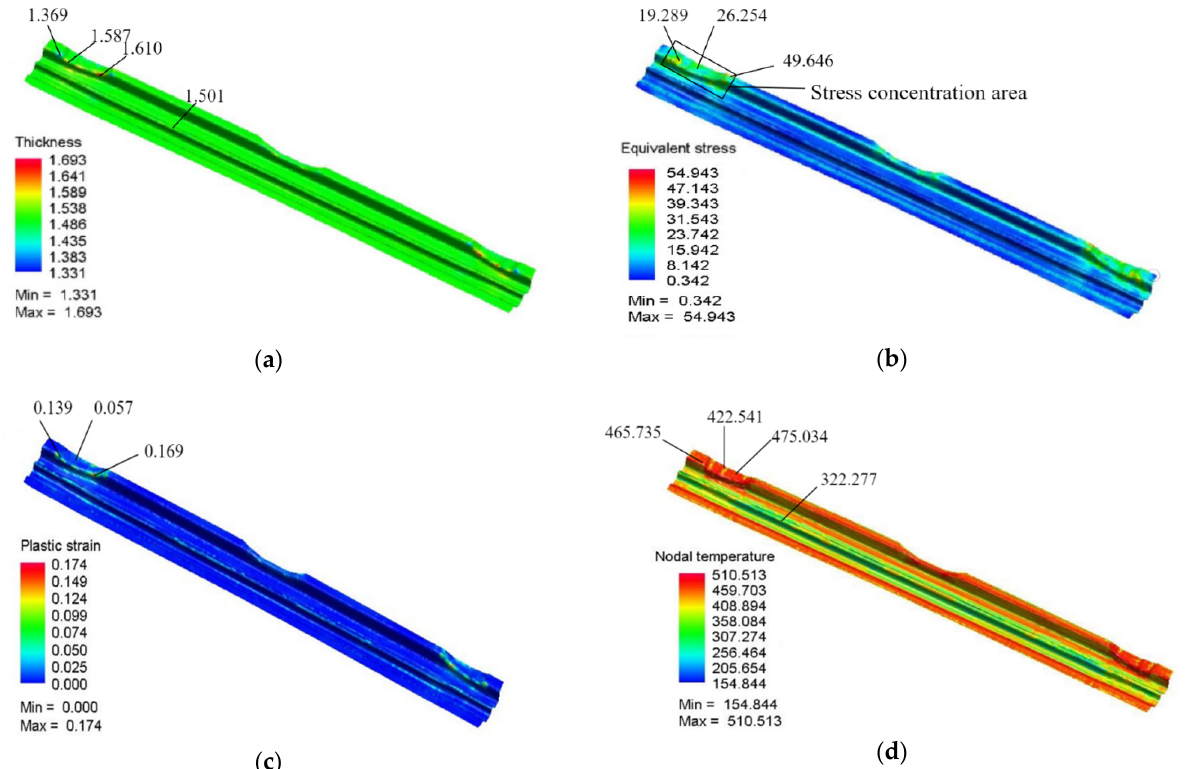
Figure 7. Distribution of simulation results: ( a ) Thickness distribution, ( b ) Stress distribution, ( c ) Strain distribution, and ( d ) Temperature distribution.